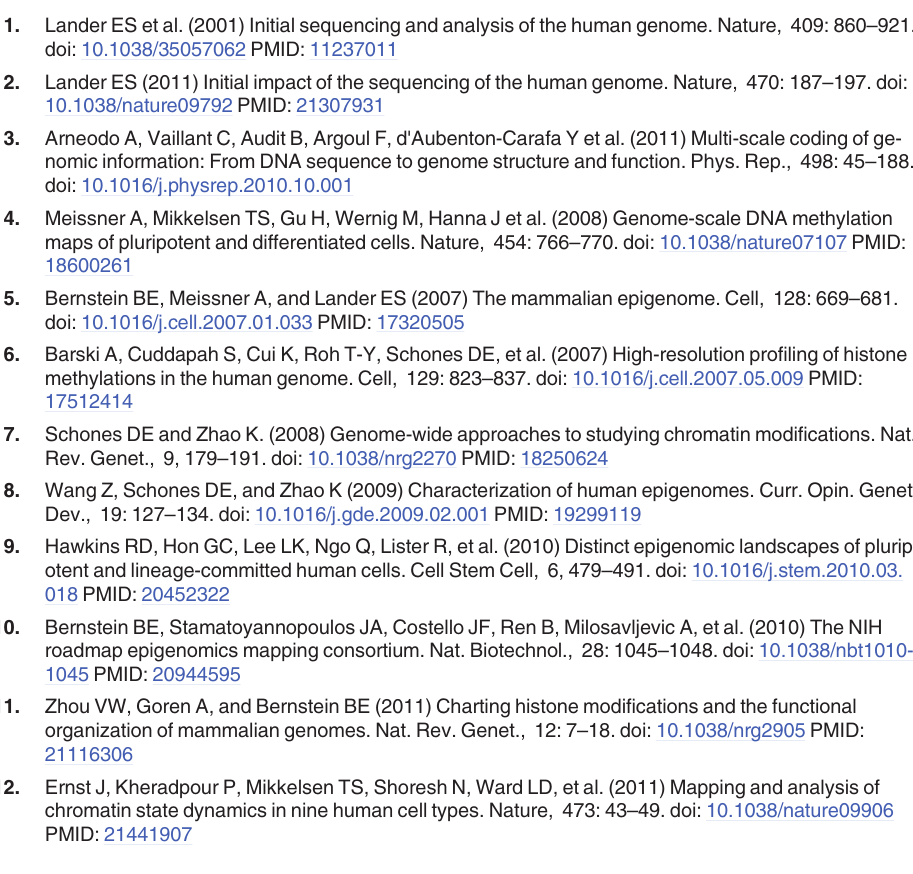
S9 Fig. Spearman correlation matrix between epigenetic marks in HeLa. Same color coding as in Fig.